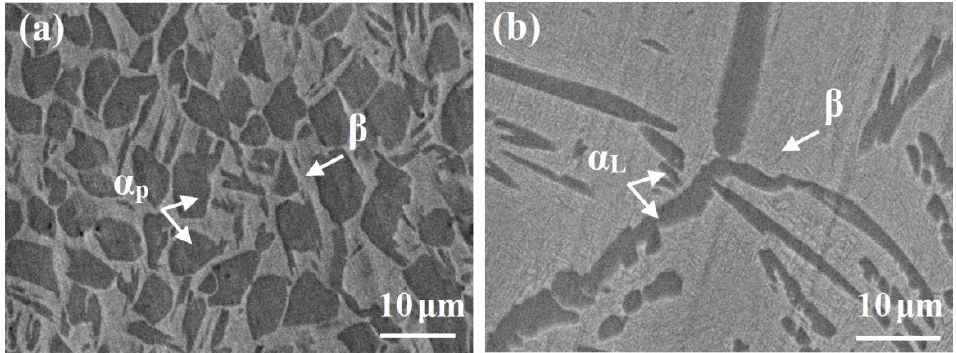
Figure 2. Microstructures after heat treatment ( a ) bimodal microstructure; ( b ) lamellar microstruc- ture.